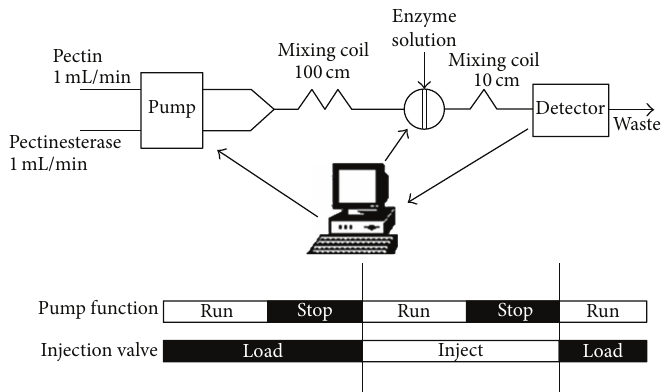
Figure 1: Manifold scheme and timing sequence of the